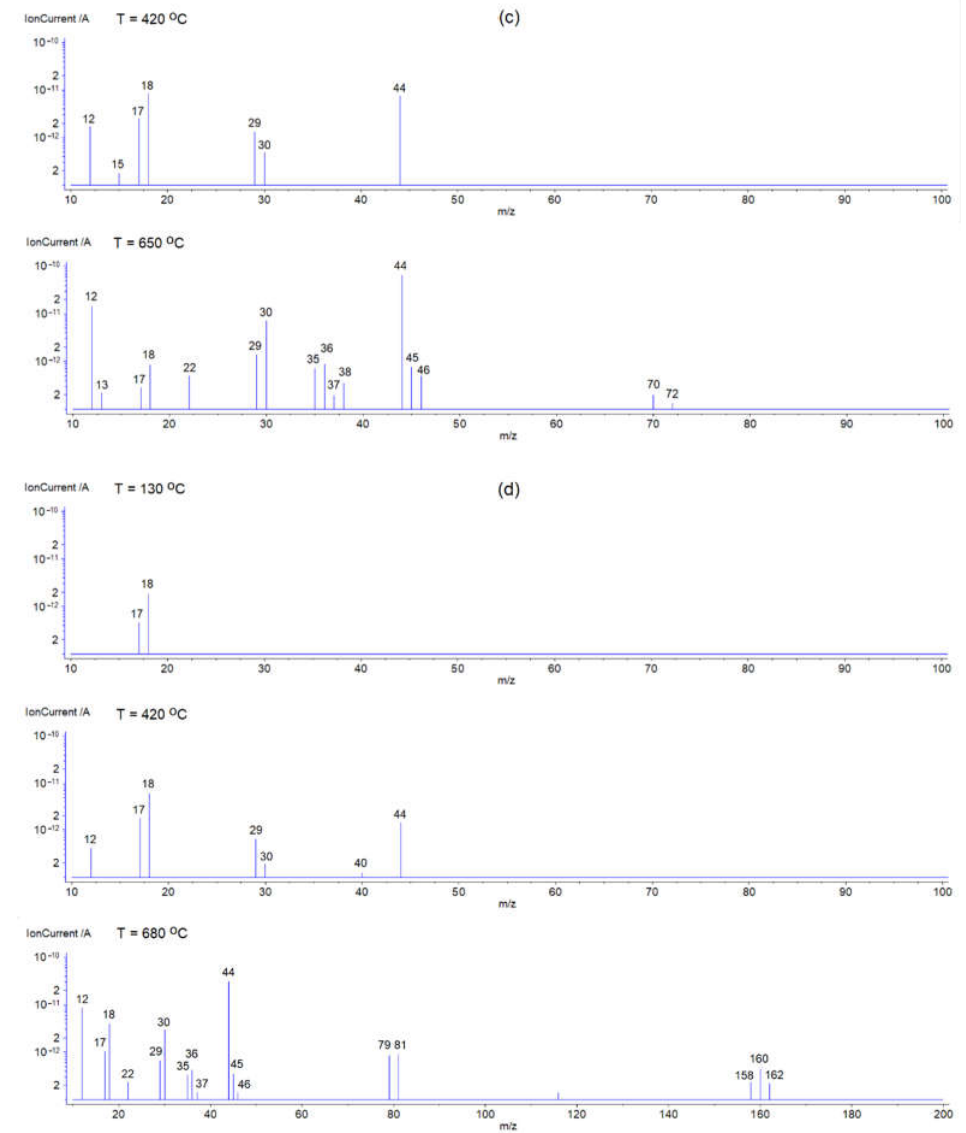
Figure 4. Mass spectra of volatile products from the thermal decomposition of complexes C1 ( a ), C2 ( b ), C3 ( c ), and C4 ( d ). The elaboration of the mass spectra involved subtracting the background spectrum and the application of the automatic software correction for the carrier gas.